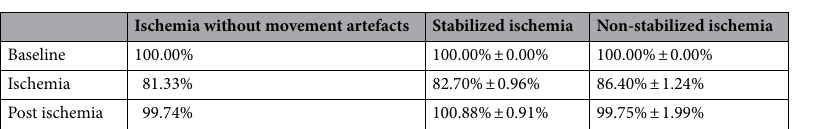
Table 1. The average measured laser speckle perfusion units (LSPU) compared to baseline calculated over the ischemic and post-ischemic periods for the ischemia without movement artefacts, for the stabilized ischemia and the non-stabilized